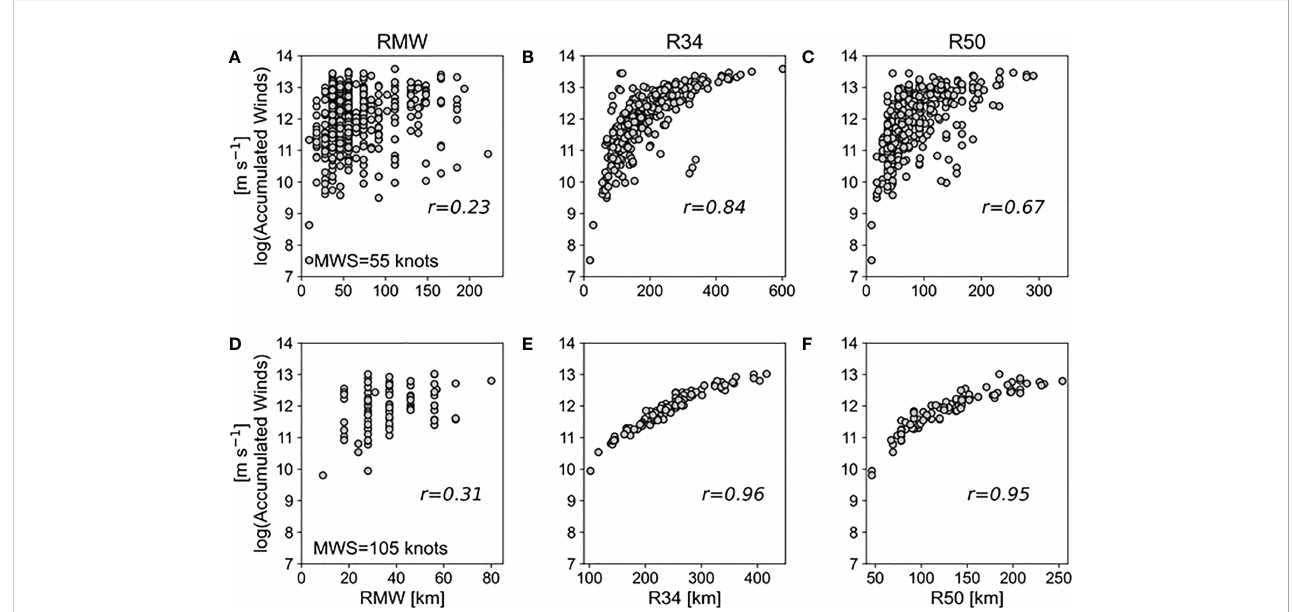
FIGURE 7 Scatter plots of the total accumulated wind within a TC against three TC size parameters: RMW (A, D) , R34 (B, E) , and R50 (C, F) . The total accumulated wind values were obtained from North Atlantic hurricanes with MWS of 55 knots (A – C) and 105 knots (D – F) by summing all the wind components aligned with the direction of propagation of the storm up to 900 km from the TC center. The correlation coef fi cients ( r ) between accumulated wind and TC size parameters are indicated in each scatter plot.